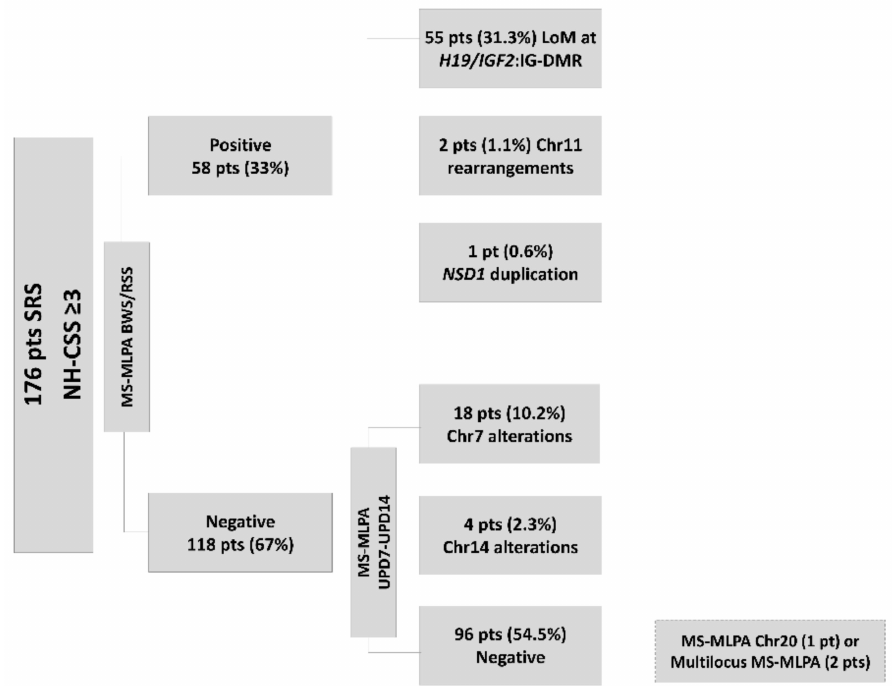
Figure 2. Flowchart for Silver Russell Syndrome (SRS)/SRS-like molecular diagnostics in our labora- tory: 176 patients with Netchine–Harbison clinical scoring system (NH-CSS) ≥ 3 were first tested for methylation defects in the 11p15 region, resulting in 55 with LoM at H19/IFG2 :IG-DMR, 2 with chromosome 11 rearrangements, and 1 with NSD1 gene duplication. In the second step, methylation- specific multiplex ligation probe-dependent amplification (MS-MLPA) for chromosomes 7 and 14 revealed 17 cases of UPD(7)mat and 4 cases with Chr14 alterations (2 UPD(14)mat and 2 cases with LoM at MEG3 -DMR). Negative patients were investigated for chromosome 20 uniparental disomy (UPD) using the approaches indicated in the rectangle framed by the broken